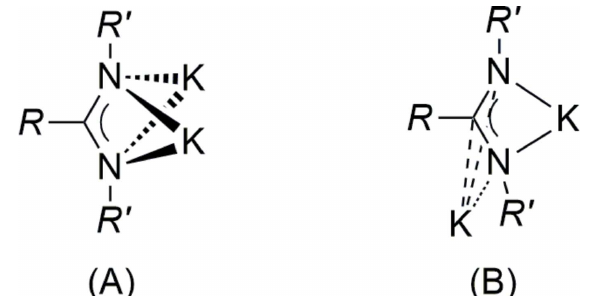
Figure 4 Coordination modes of 1,3-diazaallyl-type ligands (= amidinate or guanidinate) observed in potassium complexes: symmetric double- chelating (A), single-chelating and (cid:6) 3 -coordination of the 1,3-diazaallyl (cid:2) -system